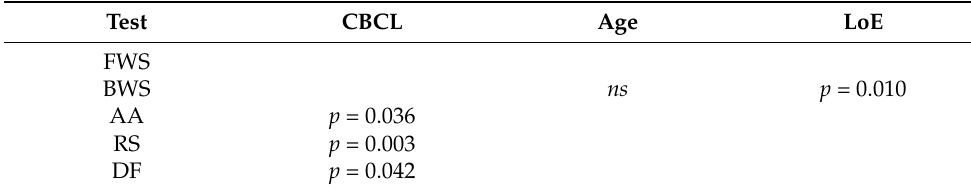
Table 4. Summary of the predictors involved in best fit models assessing the predictive role of CBCL and individual variables on executive functions. Test